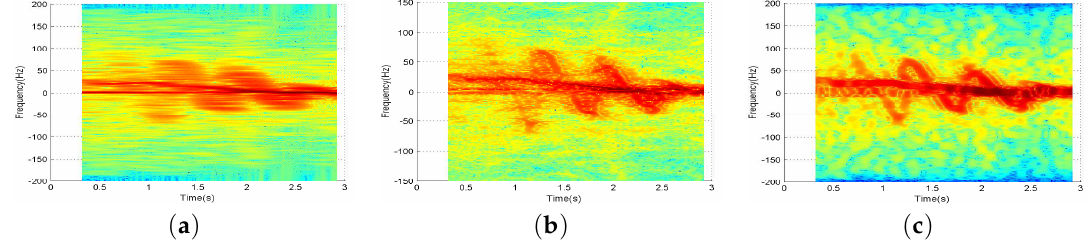
Figure 5. ( a ) is spectrogram; ( b ) is multiwindow processing; ( c ) is AS-method